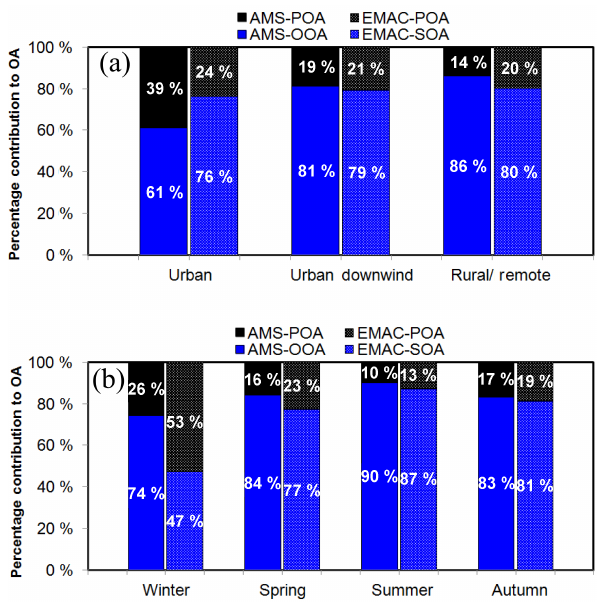
Figure 14. (a) Spatial and (b) seasonal composition of total OA mass calculated from EMAC and AMS results in the Northern Hemisphere during 2001–2010.